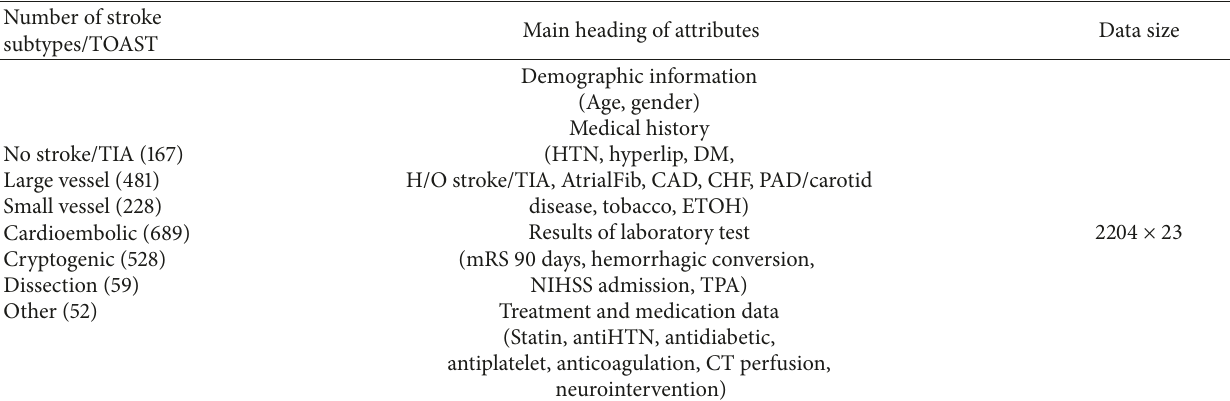
Table 2: Stroke dataset.